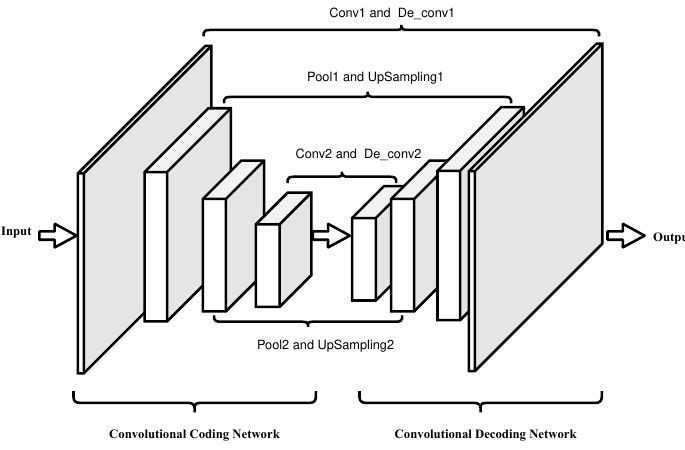
Figure 8. The structure of CAEN.